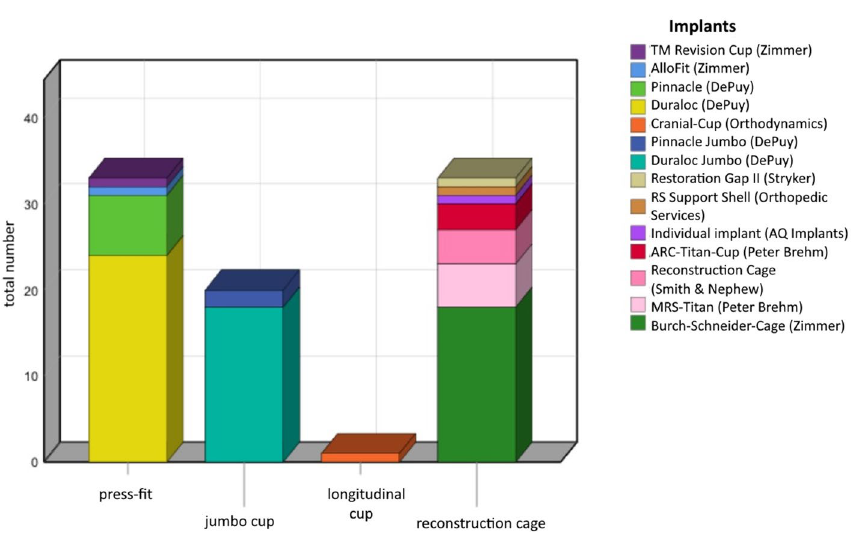
Figure 3. Categorized implants of implanted